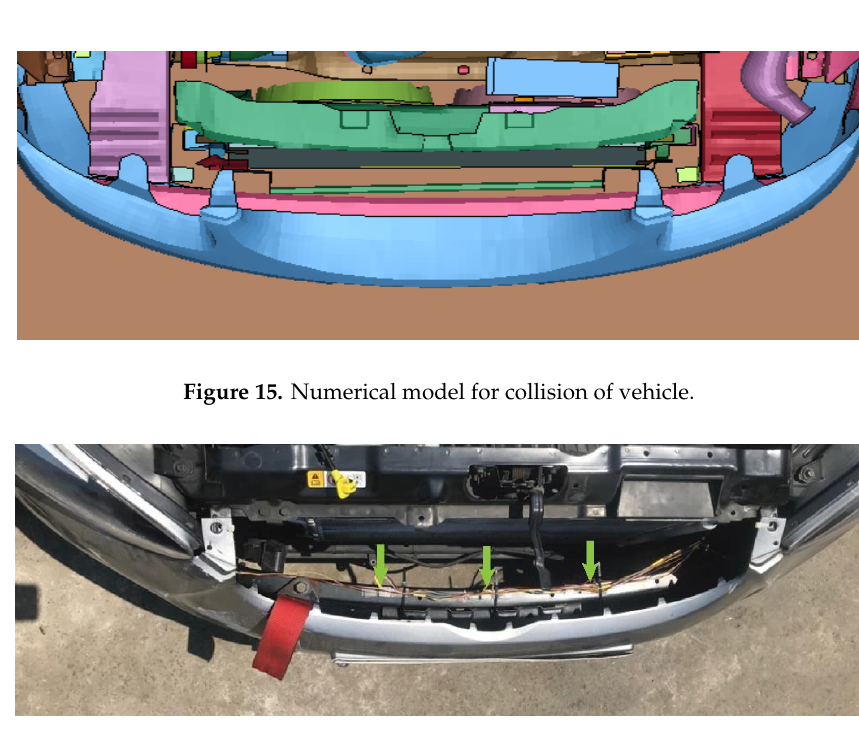
Figure 16. Test vehicle for collision and gyro sensor.